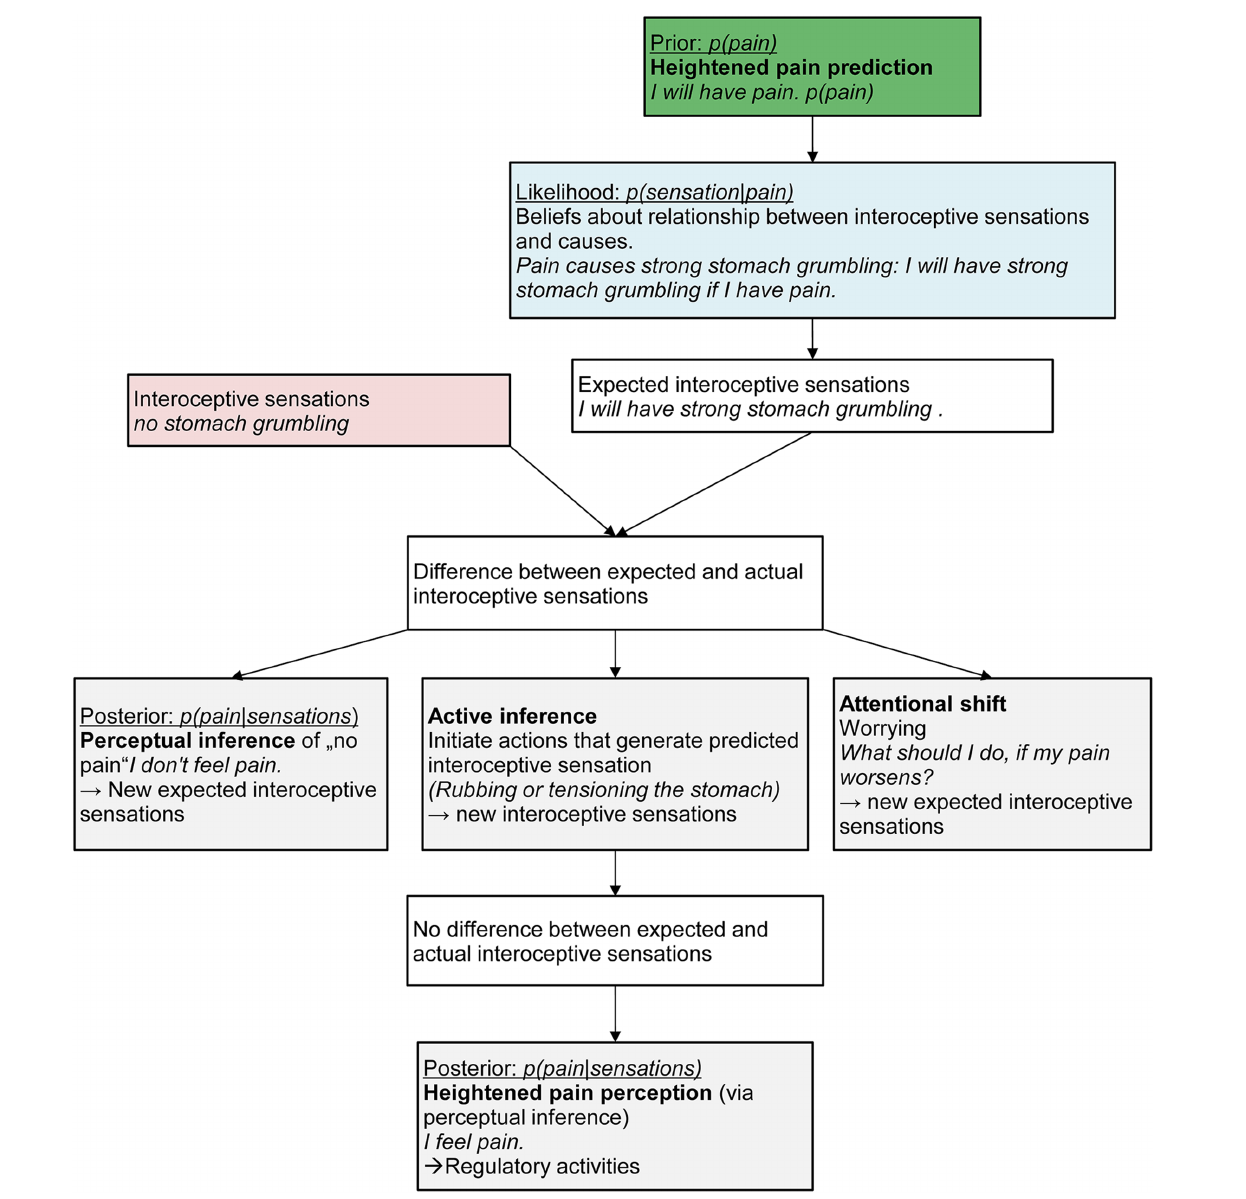
FIGURE 1 | The path from heightened prediction to perception of pain in the mind of Sarah, a 13-year old girl suffering from chronic abdominal